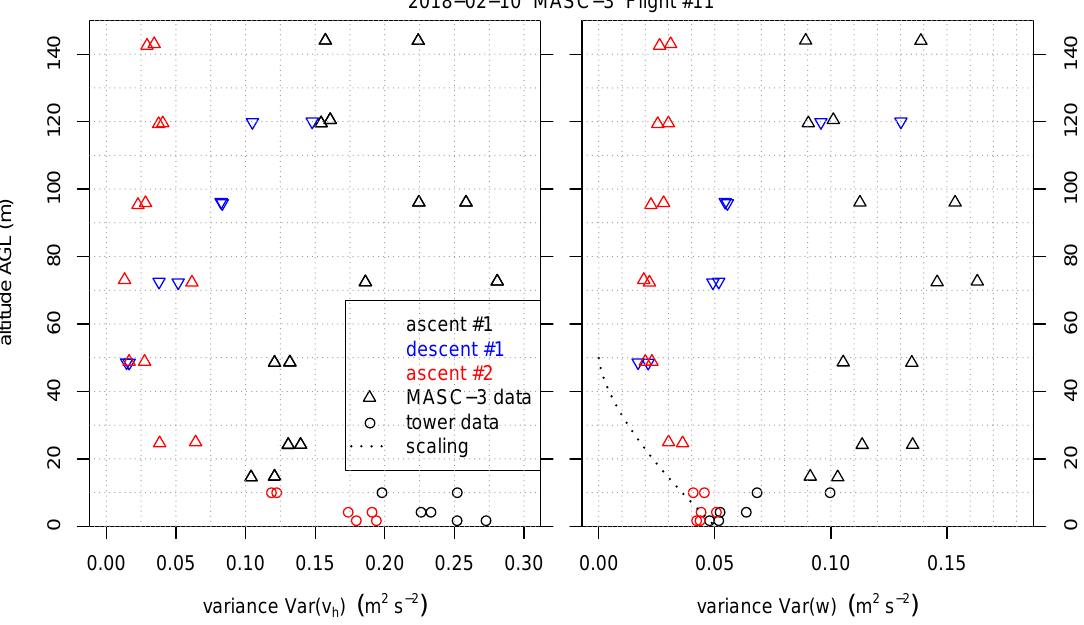
Figure 15. MASC-3 Flight #11 alongside the corresponding tower data as height profile for the variance of the horizontal wind speed Var v ( left ) and the variance of the vertical wind speed Var w ( right ). h The time series of the tower data points have a duration of ∆ t tower = 170 s, corresponding to the fetch of the MASC-3 flight legs at the lowest levels with an average duration of ∆ t UAS = 55 s. The Var w profile ( right ) inherits the scaling